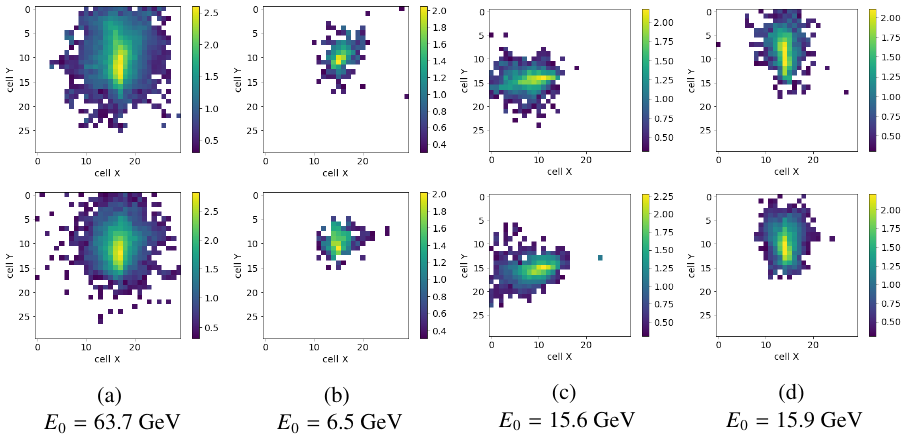
Figure 2: Visual comparison of generated calorimeter showers. Showers generated with Geant4 (first row) and the showers, simulated with our model (second row) for four di ff erent sets of input parameters. Colour represents lo g 10 ( E ) for every MeV